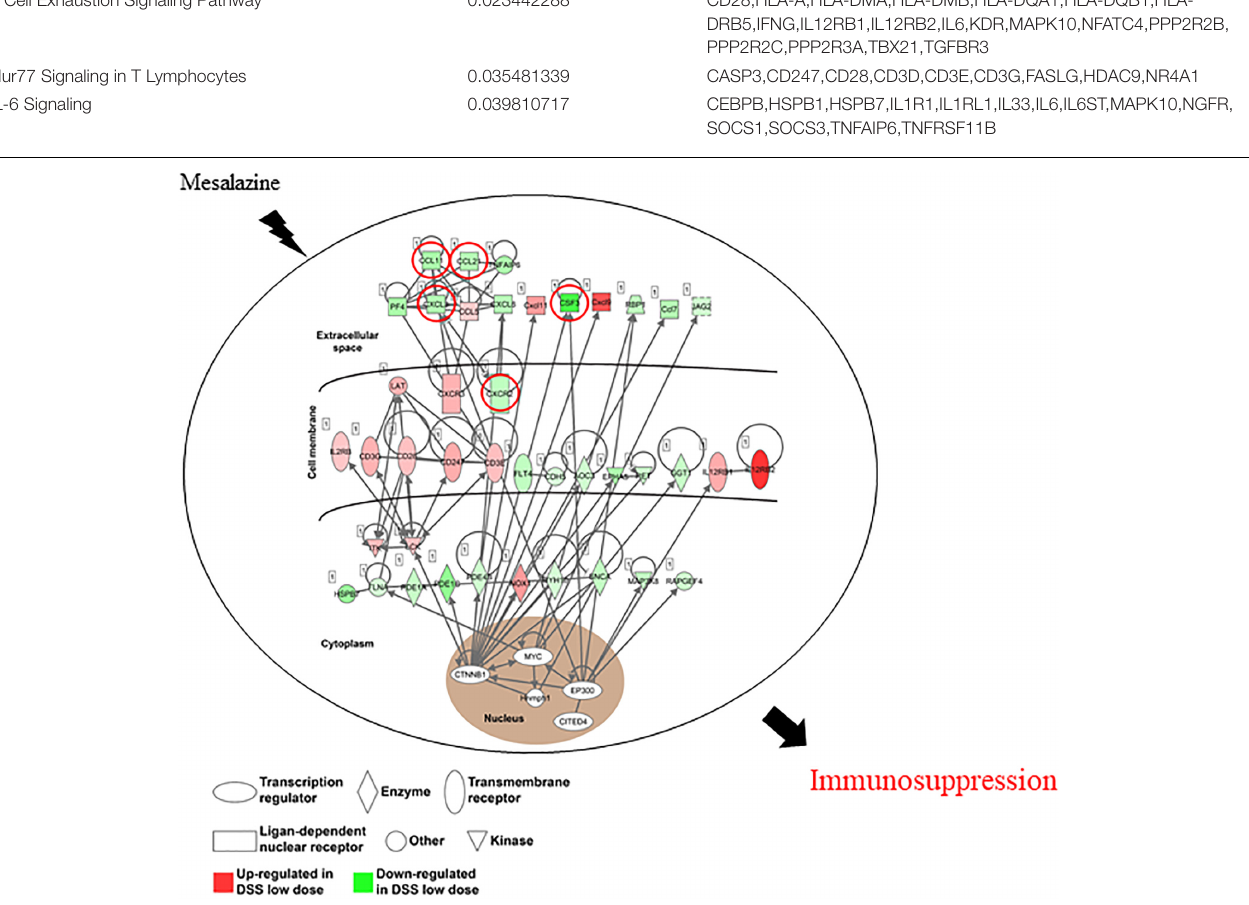
FIGURE 3 | The gene network involved in the immunosuppressive effect of mesalazine on DSS-induced colitis. Ingenuity pathway analysis shows the contribution of different molecules in the immunosuppressive effect of mesalazine. The red symbol represents upregulated genes; the green shape represents downregulated genes.